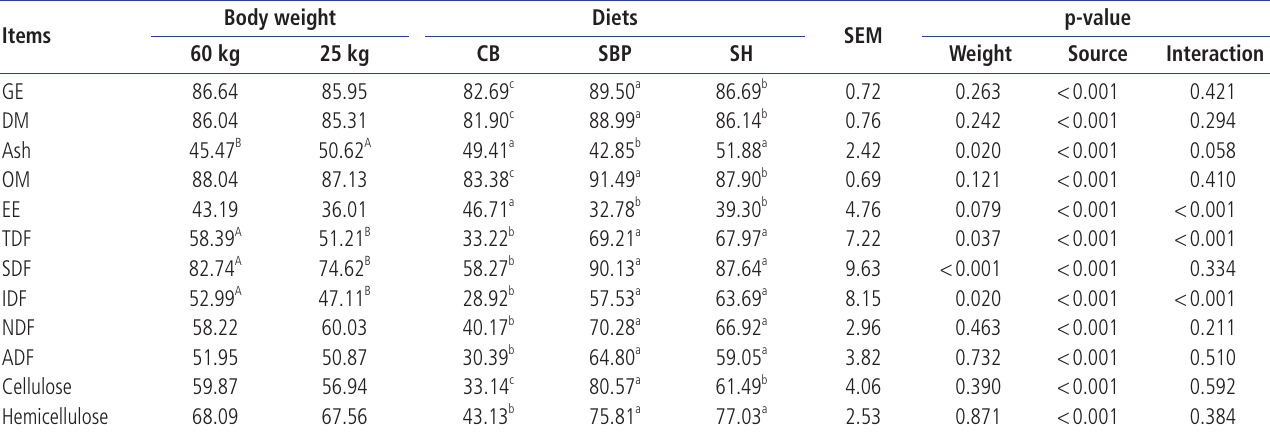
Table 6. Effects of pig body weight and fiber sources on the apparent total tract digestibility (%) of dietary nutrients 1)